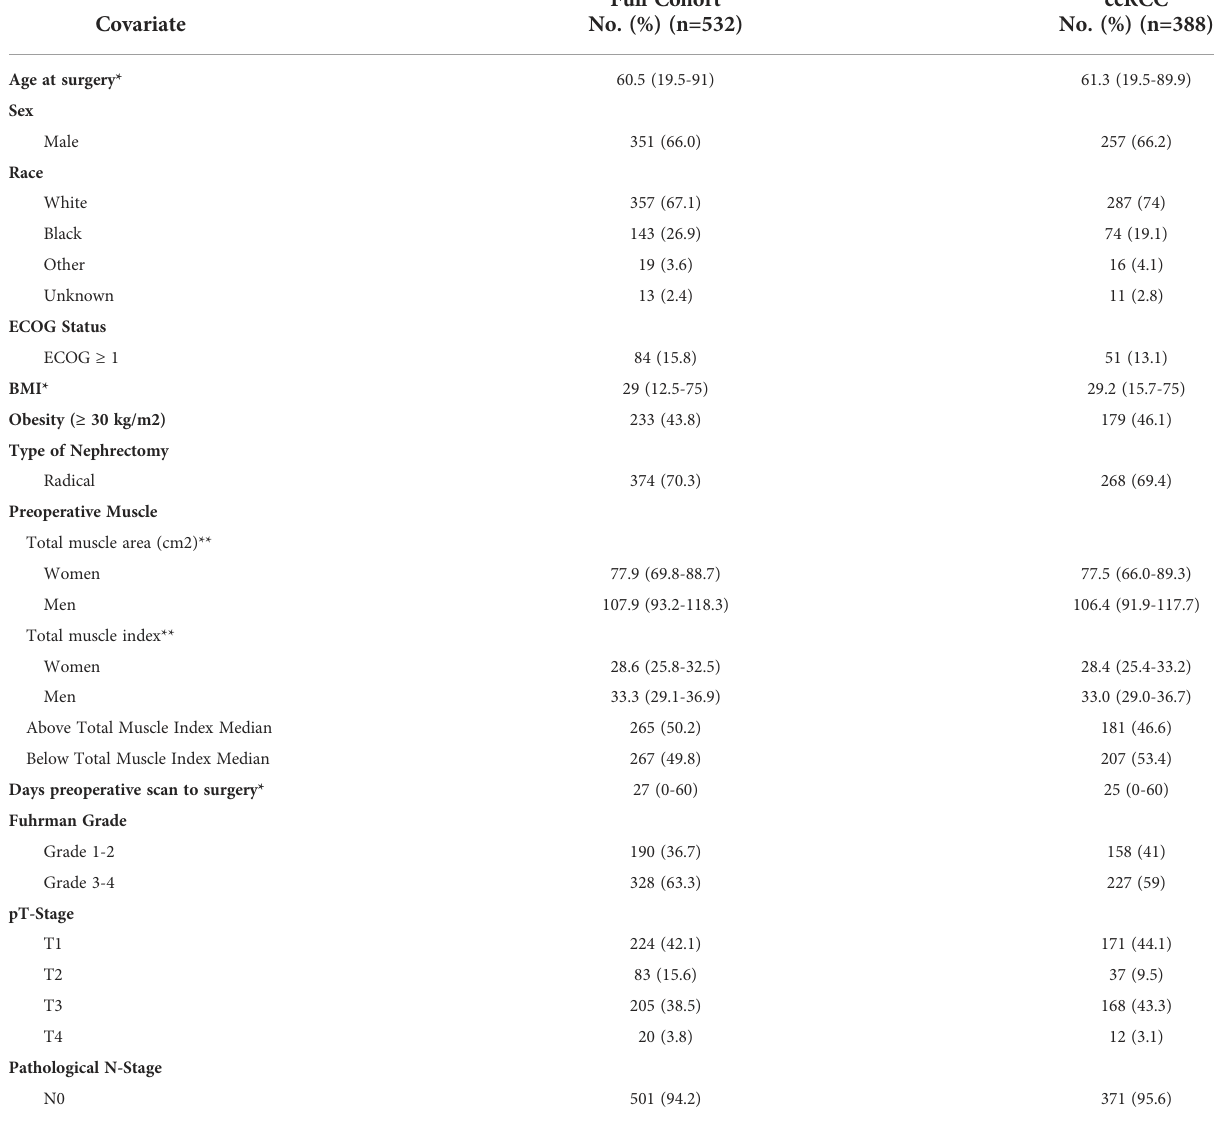
TABLE 1 Patient demographics for Localized RCC